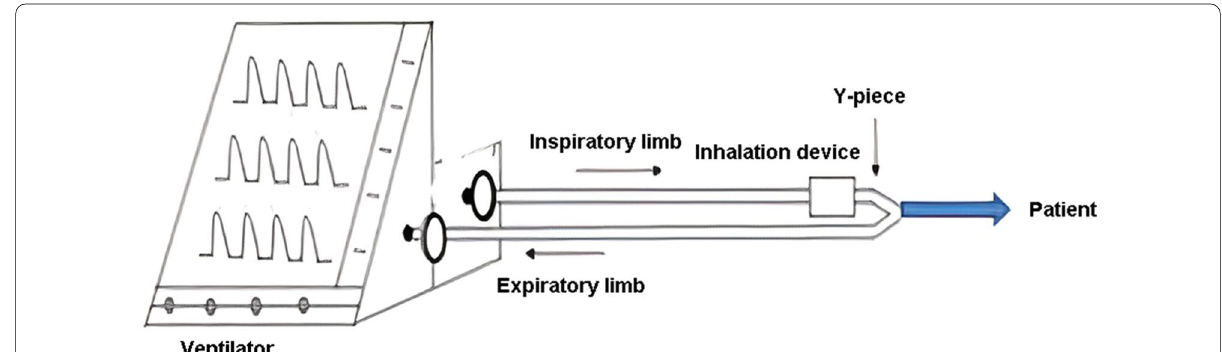
Fig. 1 Schematic diagram of in-vivo setting showing the position of the aerosol generator in case of using BiPAP circuit. Edited from